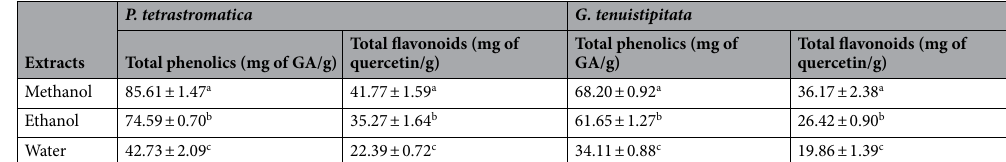
Table 3. Total phenolic and flavonoid content of P. tetrastromatica and G. tenuistipitata crude extracts. Different superscript letters represent things that are substantially different from one another. Significance level is p <